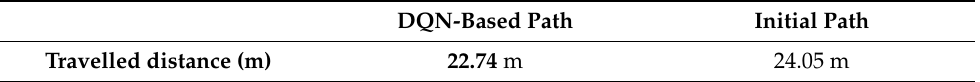
Table 8. Path optimization proposed by the 3D planner through the use of DRL